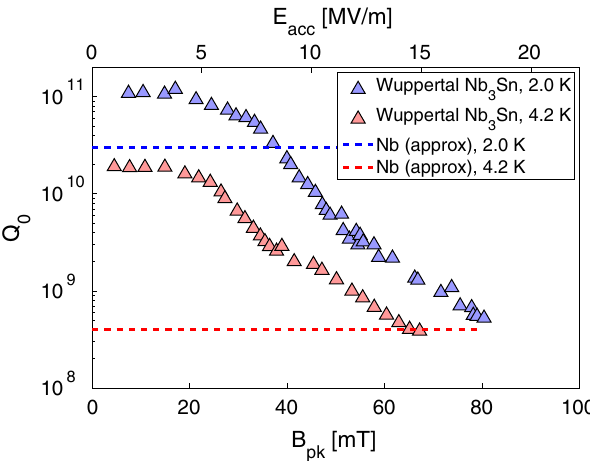
FIG. 3. Cross section of coating chamber (left), coating chamber being lowered into furnace (center), and UHV furnace with chamber inside